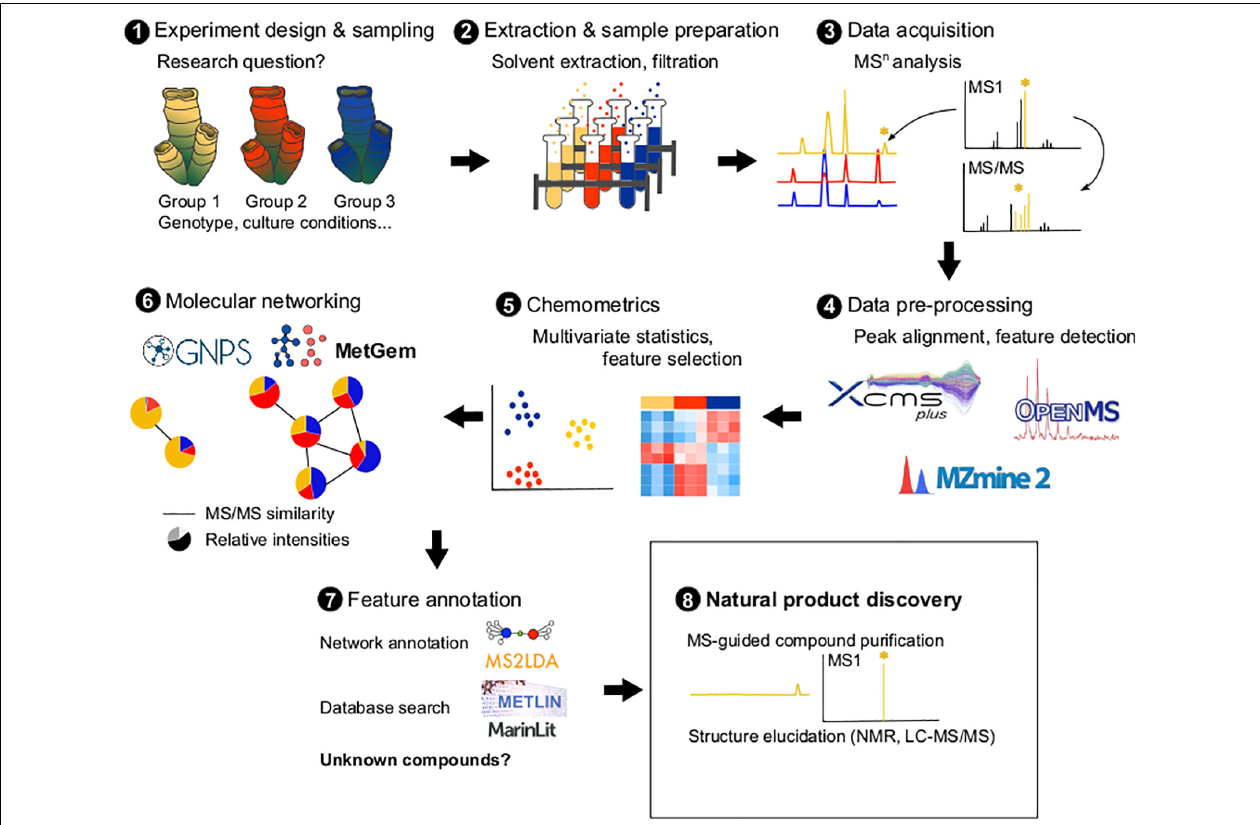
FIGURE 1 | Metabolomics pipeline illustrating the different steps: experiment design according to the biological research question (1) , sample extraction (2) , MS n analyses (3) , pre-processing the raw MS n data using softwares such as XCMS, mzMine2 or OpenMS (4) , data numerical analyses to identify patterns and select interesting metabolites (5) , molecular networking analysis using tools such as GNPS or MetGem (6) , network and metabolite annotation using tools such as MS2LDA or databases (Metlin, MarinLit) (7) , and purification and elucidation of new natural products (8)